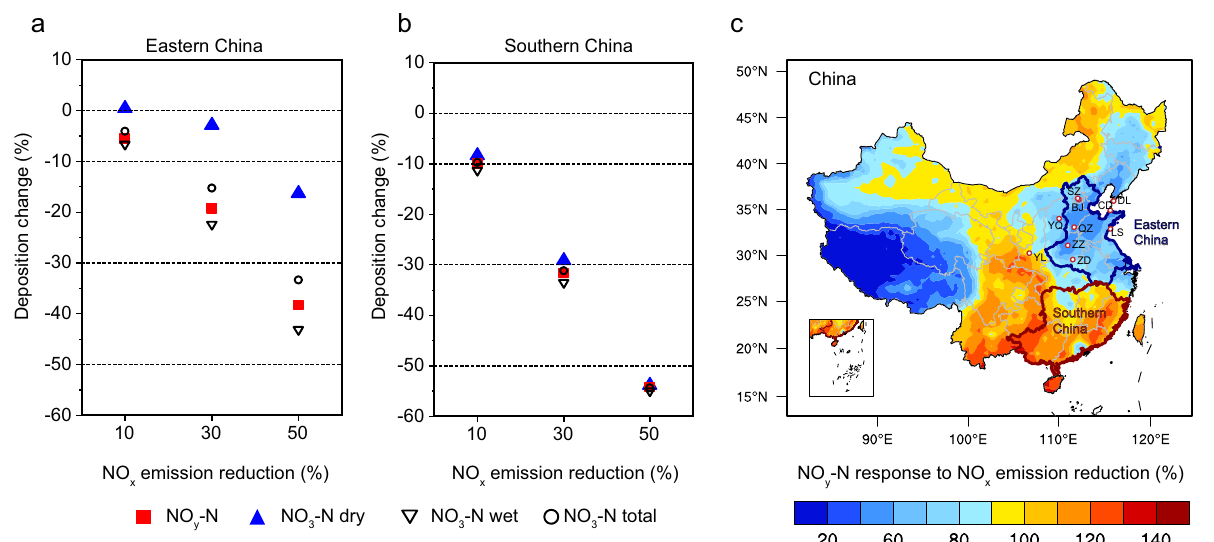
Fig. 2 Response of NO y -N deposition to 10, 30, and 50% reductions of NO x emission. a The percent changes of NO y -N (NO x and its oxidation products) deposition, NO 3 -N (nitric acid and nitrogen pentoxide) dry deposition, NO 3 -N wet deposition, and NO 3 -N total deposition in Eastern China. b The percent changes of NO y -N deposition forms in Southern China. c Spatial distribution of the relative response of NO y -N deposition to the 30% NO x emission reduction. The dots in panel c denote the ten observation stations for N deposition fl uxes during 2011 – 2015. Note that values of the relative responses less than 100% in c represent the percent reductions of NO y deposition lower than the reductions of NO x emission. The map of China was reproduced from the National Geographic Information Resource Directory Service System (https://github.com/huangynj/NCL-Chinamap.git and https://www.webmap.cn/ commres.do?method =